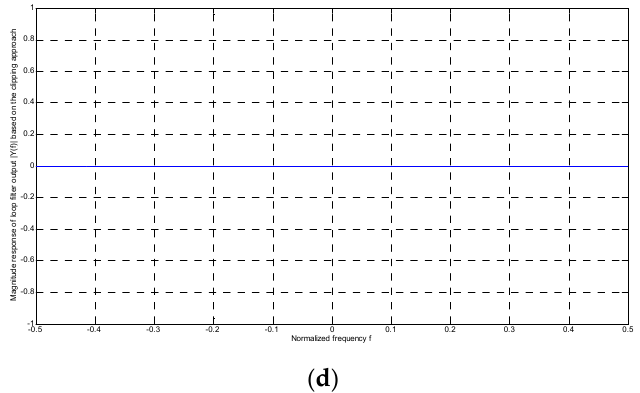
≥ k = ku for 0 under our proposed control ≥ k = ku for 0 under the clipping strategy ≥ k = ku for 0 under